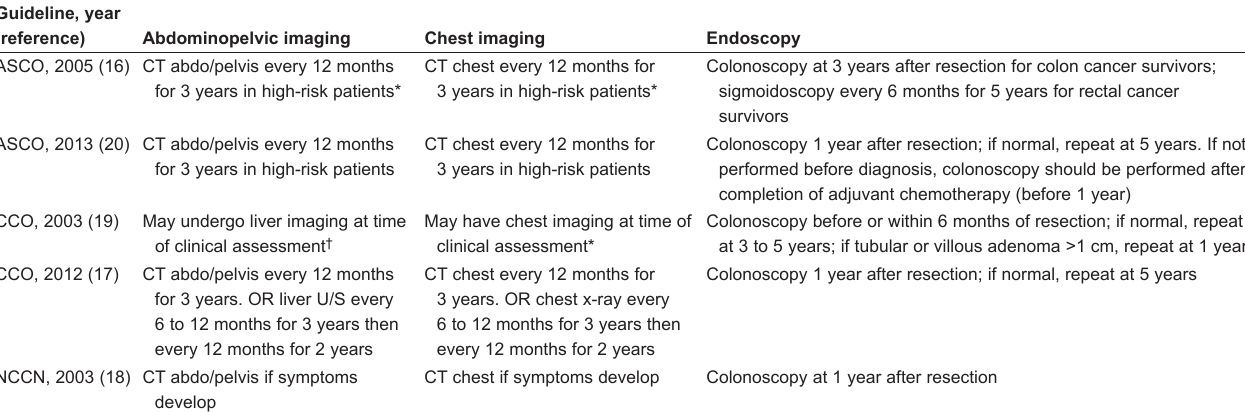
TAble 1 Variation in surveillance guidelines for patients after a curative-intent colorectal cancer resection Guideline,